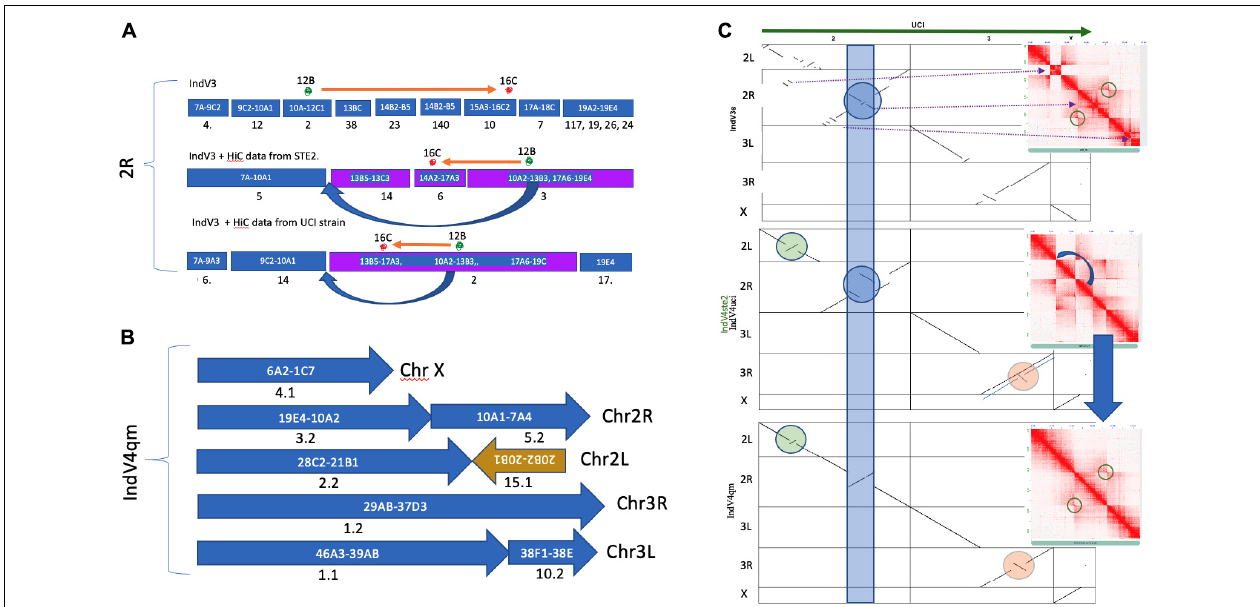
FIGURE 3 | Homology-based scaffolding. (A) Scaffolds after homology-based scaffolding covering the range of physical markers for only 2R. (B) Karyogram of IndV4. (C) Dot plot of UCI assembly against all assemblies of the STE2 strain reported here including IndV3s (top), IndV4uci/IndV4ste2 (middle, only 3R is different), and IndV4qm (bottom). Inset shows contact maps of the 2R arm with HiC reads from the STE2 strain against the respective STE2 assemblies. The blue curved arrow shows the manually moved block. The blue strip, green, and peach circles highlight potential inversions against UCI assembly in respective STE2